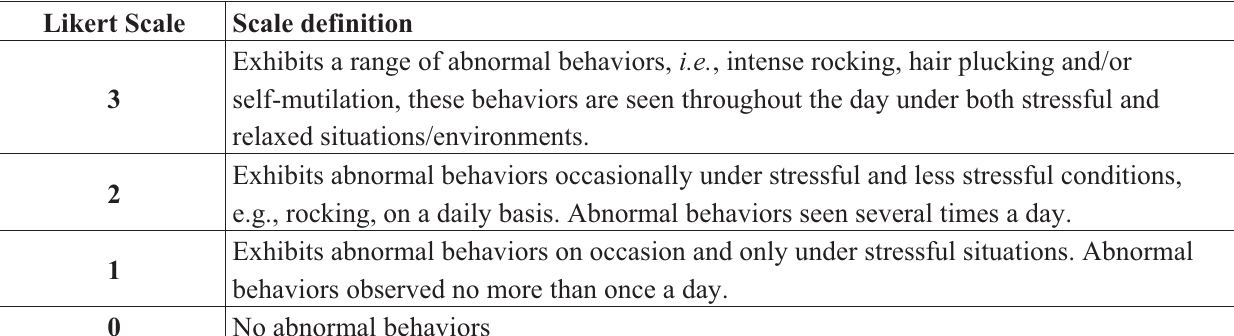
Table 2. Summary of scale used to quantify the degree of aberrant or stereotypic behaviors exhibited by each orphan upon arrival at the sanctuary. Experienced keepers, staff members and long-term volunteers who were present at the time were asked to score each chimpanzee independently. The final score for each individual was averaged based on a minimum of five scorers.